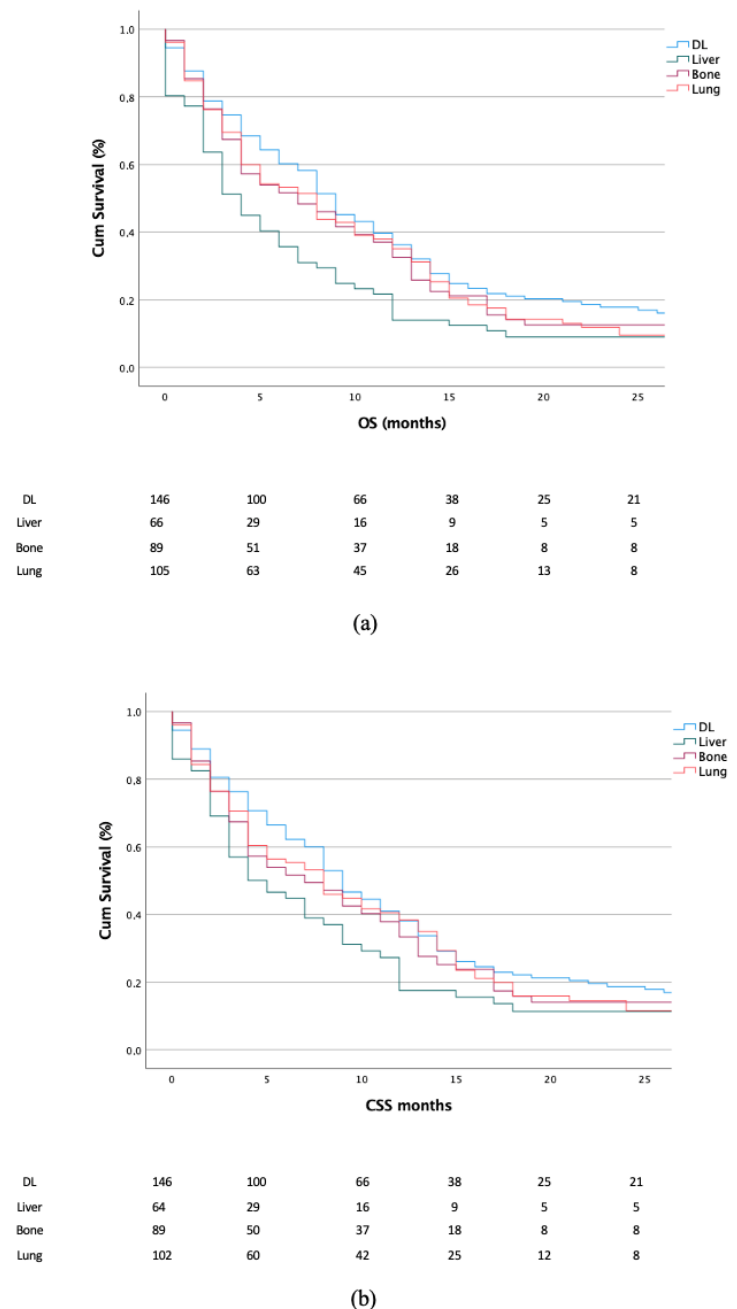
Figure 2. Kaplan–Meier plots depicting OS ( a ) and CSS ( b ) according to different metastatic organs in patients presenting single-organ metastases. DL, distant lymph node.